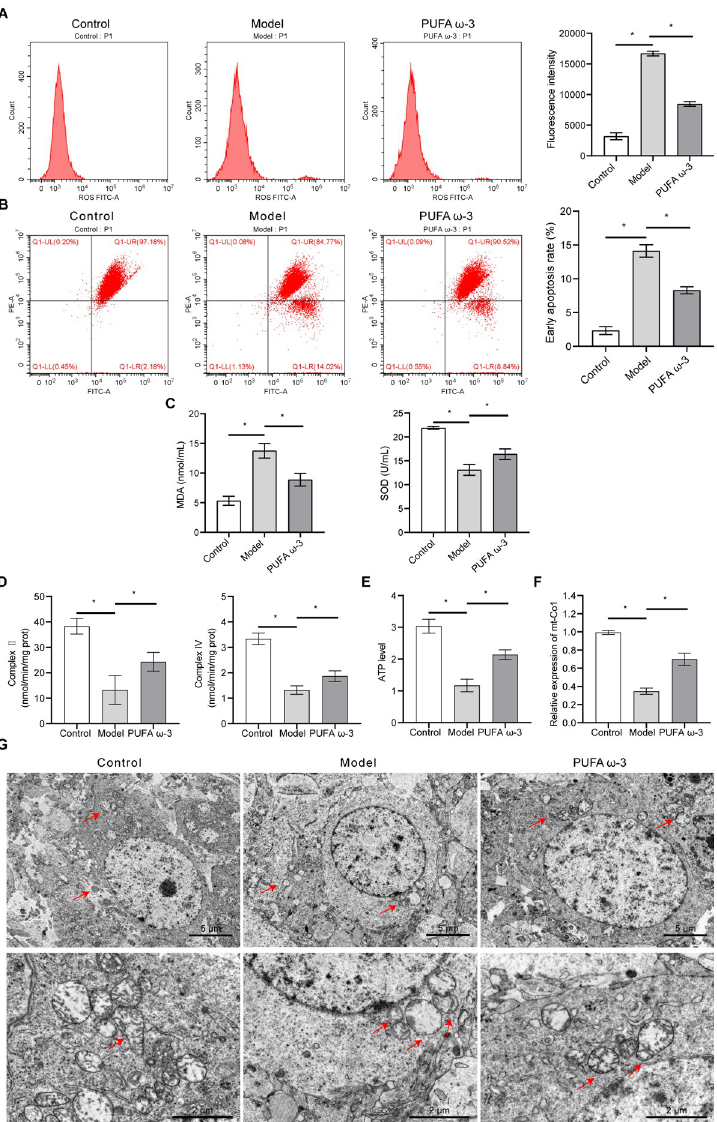
Fig 5. PUFA ω -3 reduces mitochondrial damage induced by sodium nitrite exposure in fetal cortical tissue. (A-B) ROS and JC-1 levels in the cerebral cortex of fetal rats as determined by flow cytometry, n = 3 rats/group. (C) Plasma MDA and SOD levels of fetal rats in different groups were detected by ELISA, n = 3 rats/group. (D-E) Mitochondrial complex II, mitochondrial complex IV, and ATP activity were measured by ELISA, n = 3 rats/group. (F) mt-Co1 expression detected by qRT-PCR, n = 3 rats/group. (G) Mitochondrial damage observed using TEM, n = 3 rats/group. Red arrows indicate mitochondria. Scale bars: 2 μ m and 5 μ m. � P < 0.05. MDA, malondialdehyde; qRT-PCR, quantitative real-time PCR; ROS, reactive oxygen species; SOD, superoxide dismutase; TEM, transmission electron